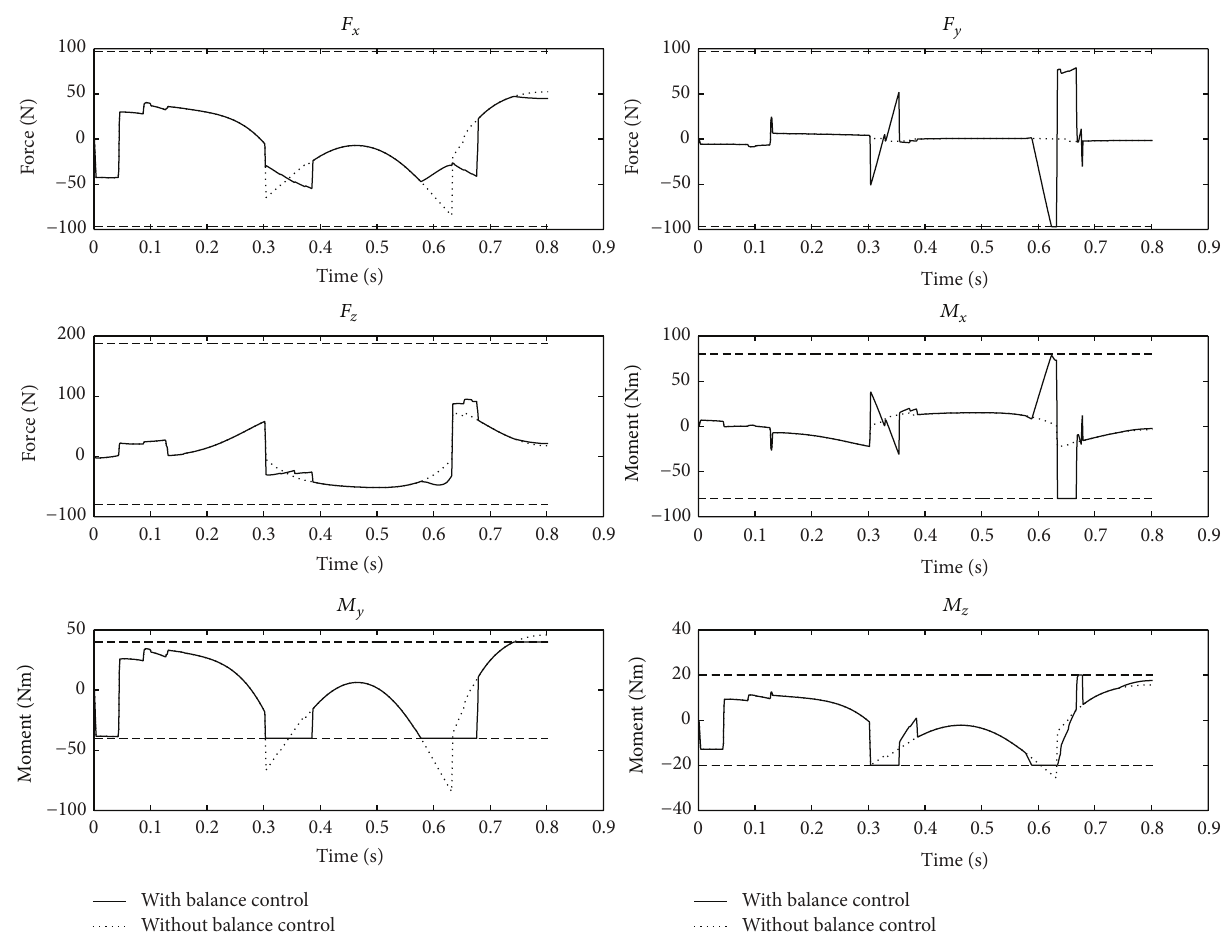
Figure 5: Momentum change rate curve of the